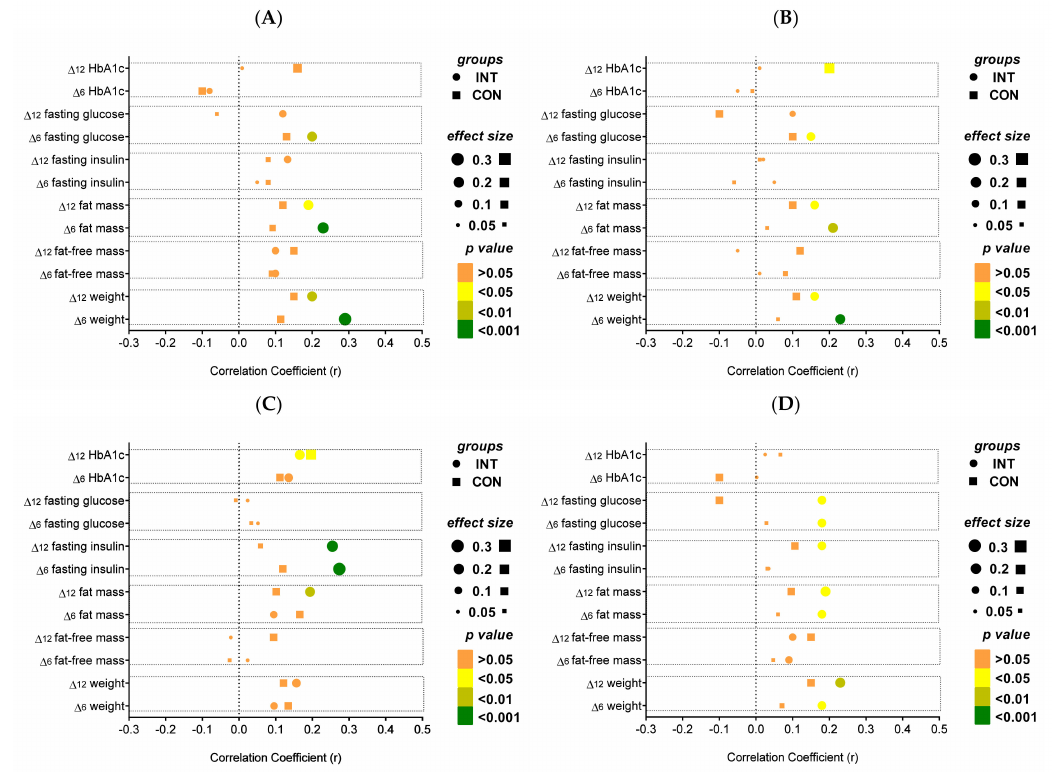
Figure 2. Correlation of changes in clinical parameters with changes in ( A ) SBP, ( B ) DBP, ( C ) resting HR, and ( D ) PWV after 6 and 12 months of intervention. Effect size and significance are shown for INT and CON. ∆ 6 = change after 6 months; ∆ 12 = change after 12 months. CON, control group; DBP, diastolic blood pressure; HbA1c, hemoglobin A1c; HR, resting heart rate; INT, intervention group; PWV, pulse wave velocity; SBP, systolic blood pressure.